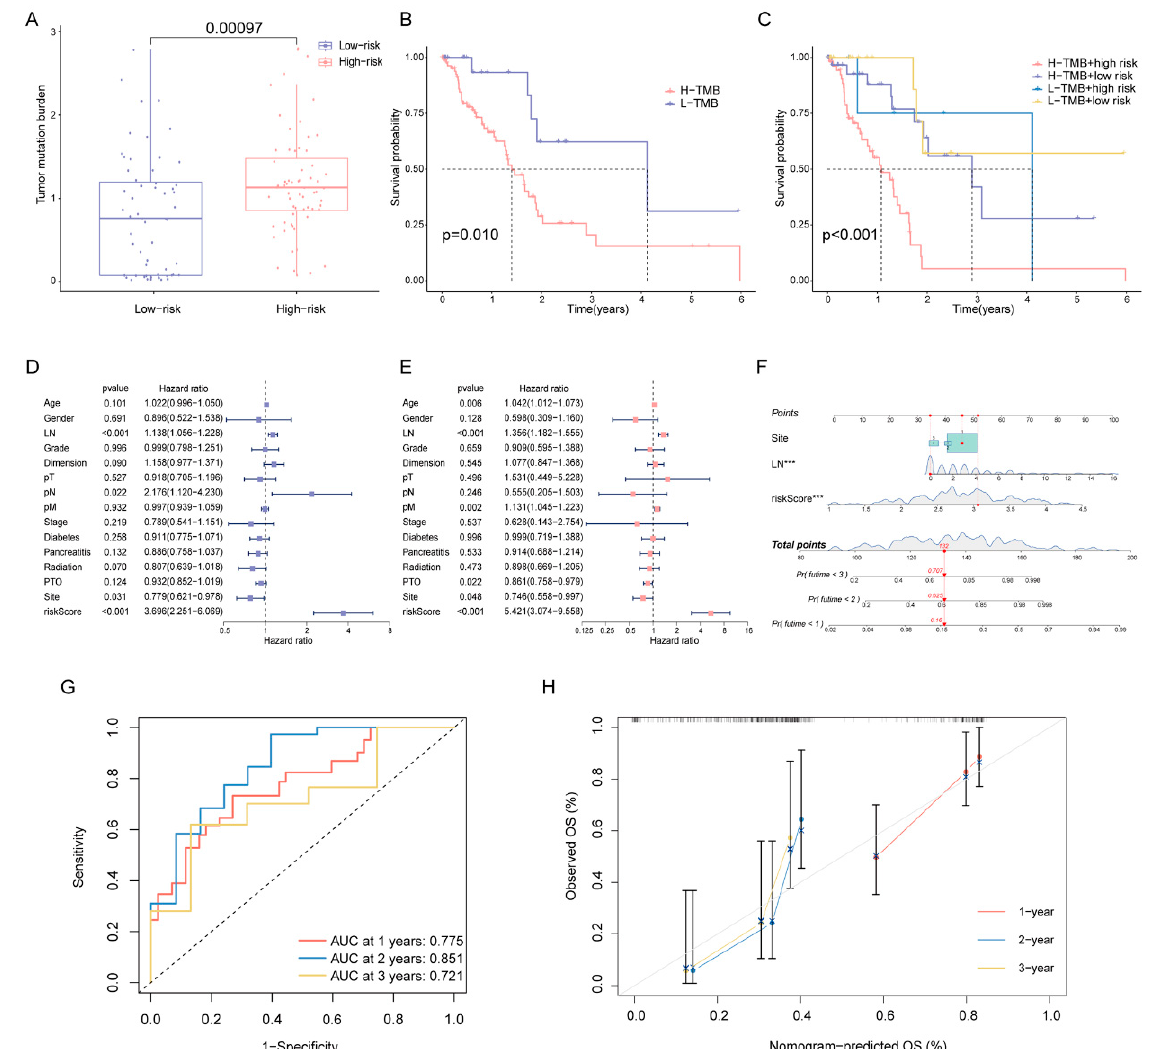
Figure 7. Correlation of risk score with TMB and clinical characteristics ( A ) Comparison of TMB between two DDR subtypes. ( B ) The OS of patients in the high- and low-risk groups. ( C ) The OS of patients in the risk groups combined with the TMB groups. ( D ) Univariate Cox analysis and ( E ) multivariate Cox analysis of clinical characteristics. ( F ) Nomogram predicting OS for PAAD patients. Time-dependent ROC curves ( G ) and calibration curves ( H ) validation at 1, 2, and 3 years of prognostic value in nomogram. *** represents p < 0.001.